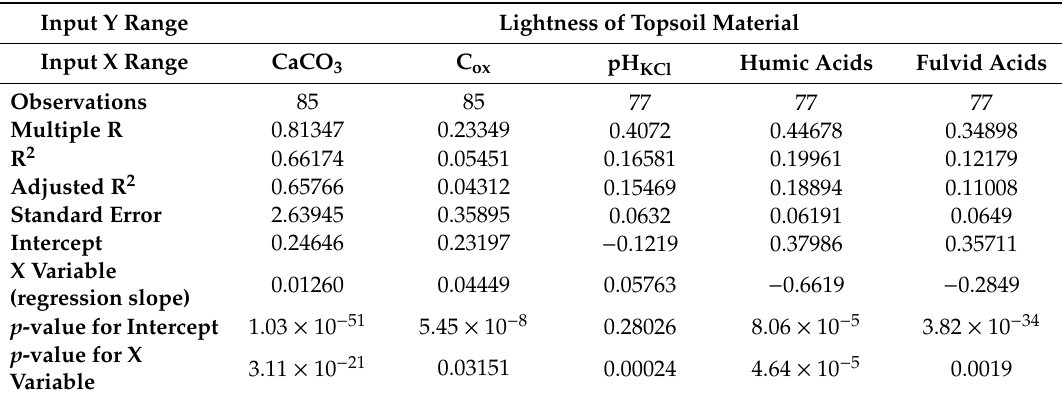
Table 2. Summary of bivariate linear regression models between soil sample colour and soil